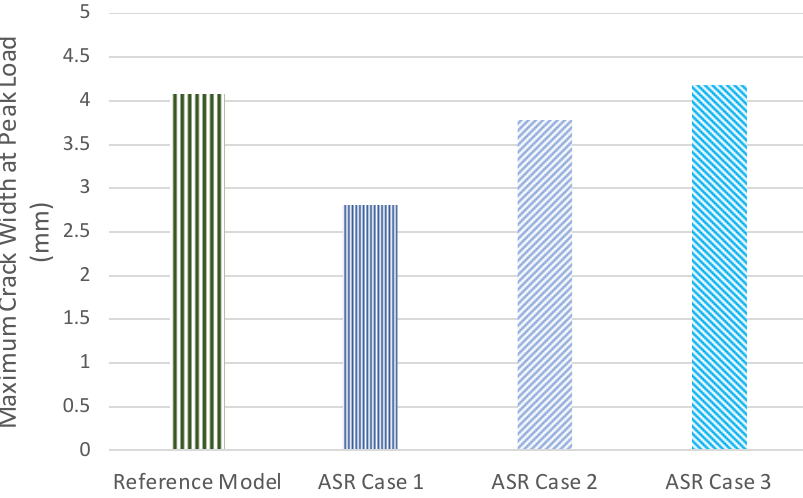
Figure 16. Maximum crack width at peak load for different cases of ASR.